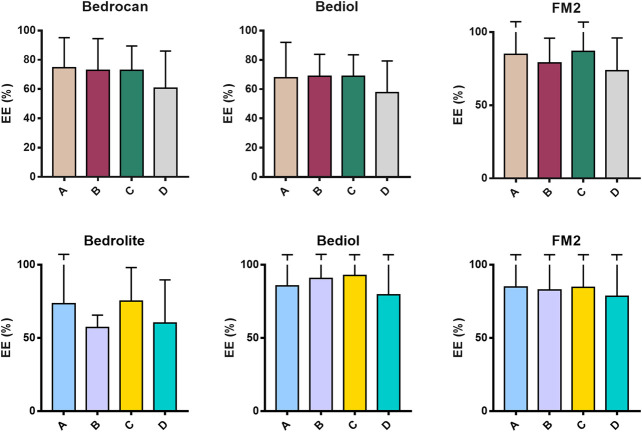
Extraction efficiency (EE%) of THC (up) and CBD (down) measured in cannabis oil samples (4,774) obtained using different cannabis varieties and preparation methods. The error bars that exceed the axis limit are represented as clipped. The theoretical extraction rate was set as the mean of the declared range content as follows: Bedrocan THC 2.05 (% w/w); Bediol THC 0.65 (% w/w), CBD 0.75 (% w/w); FM2 THC 0.65 (% w/w); CBD 1.05 (% w/w); and Bedrolite CBD 0.85 (% w/w). For details on preparation methods, see the following references: Method A (Romano and Hazekamp, 2013), Method B (Citti et al., 2016), Method C [Società Italiana Farmacisti Preparatori (SIFAP), 2016; Casiraghi et al., 2018)], and Method D (Calvi et al., 2018). The values are expressed as mean ± SD and calculated according to the equation EE% = (conc. Exp/conc. Theo) × 100.